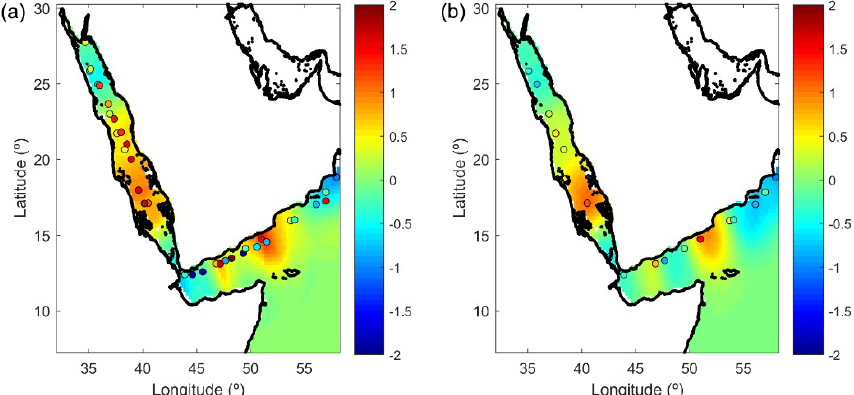
Figure 6. Analysed temperature anomaly field for October 1958 (a) and November 1958 (b) . The dots represent the location and value of the observations used in the analysis of each